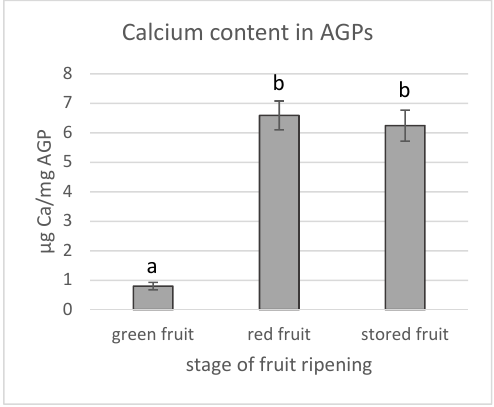
Figure 3. Qualitative analysis of calcium content in AGPs extracted from green, red and stored apple fruit ( a ). Results are expressed in µg of calcium per mg of AGPs. Different letters indicate significant differences among the development stages (according to ANOVA with p < 0.05).